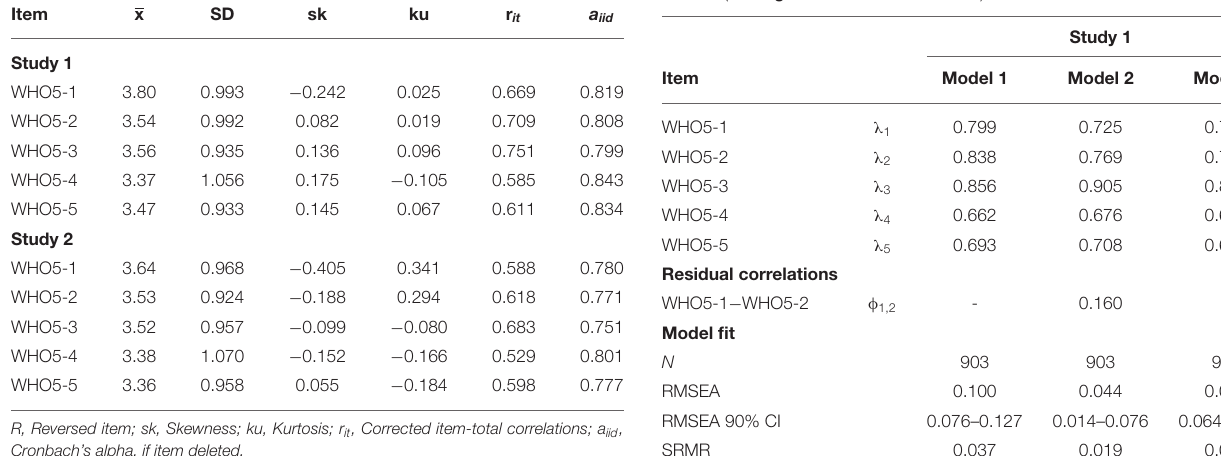
TABLE 3 | Factor loadings and fit indices in confirmatory factor analysis for the WHO-5 (see Figure 1 for estimated